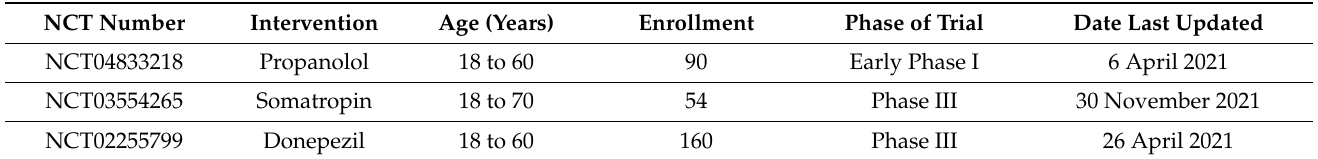
Table 2. Studies active but not recruiting (as of 3 December 2021).